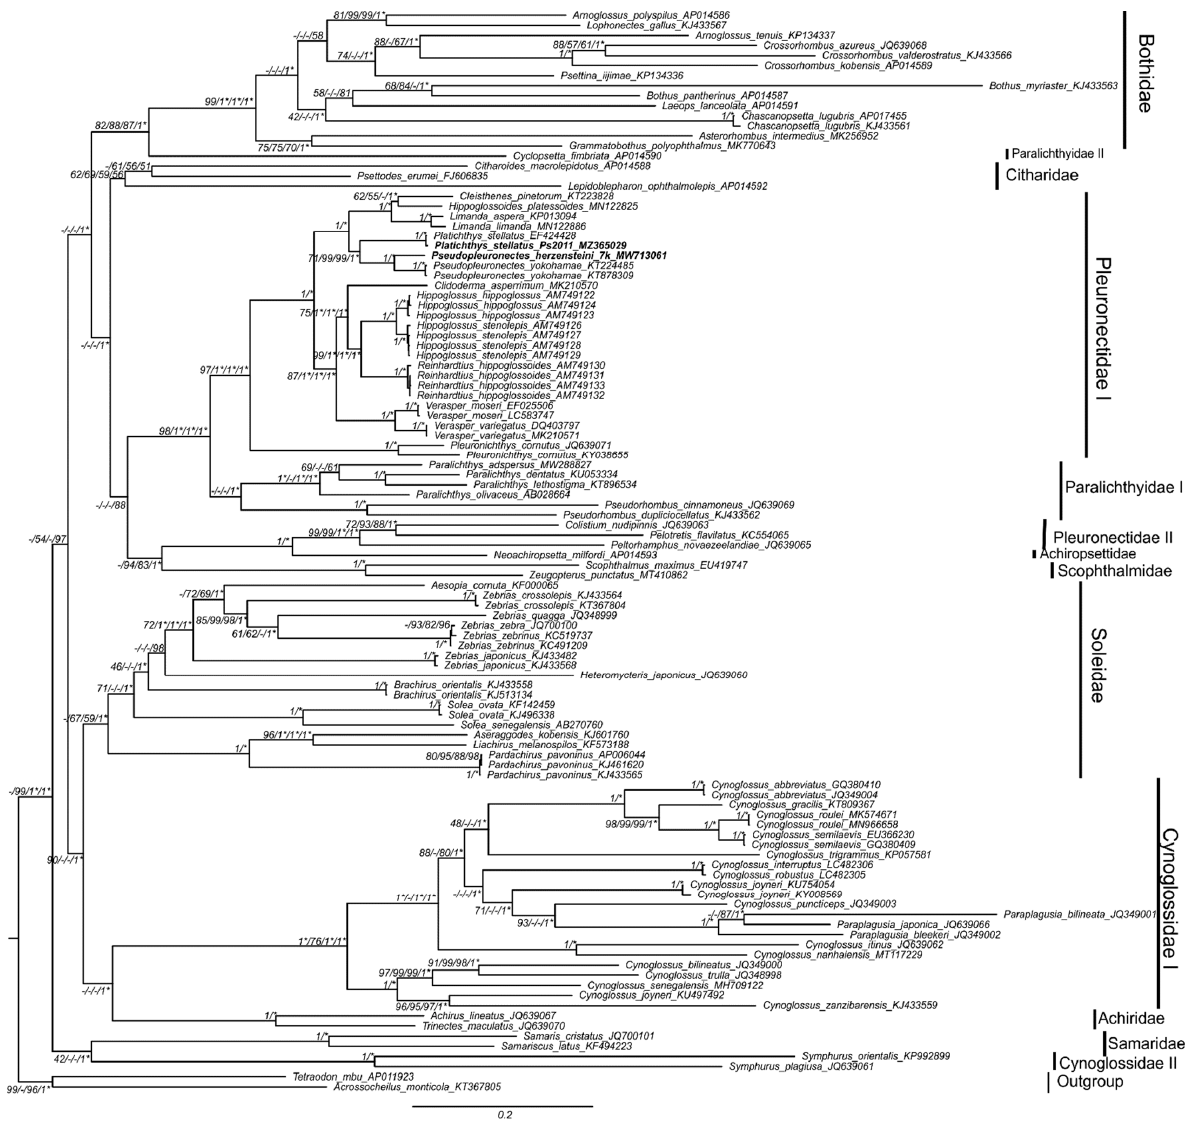
Figure 5. Rooted gene tree of the studied representatives of the suborder Pleuronectoidei constructed from PCGs of 108 mitogenomes. The topology of the gene tree is reconstructed using the BA approach. The numbers at the nodes are support values for the four tree reconstruction techniques that are placed in the order: MP/ML/NJ/BA. The posterior probabilities (%, n = 10 6 generations) are shown for the BA tree, the bootstrap support values (k = 1000 replicas) are given for the other three reconstructions. Dash means absence of support for the current node in the reconstruction by a certain technique. Support values that equal to 100% shown for convenience by the asterisks.